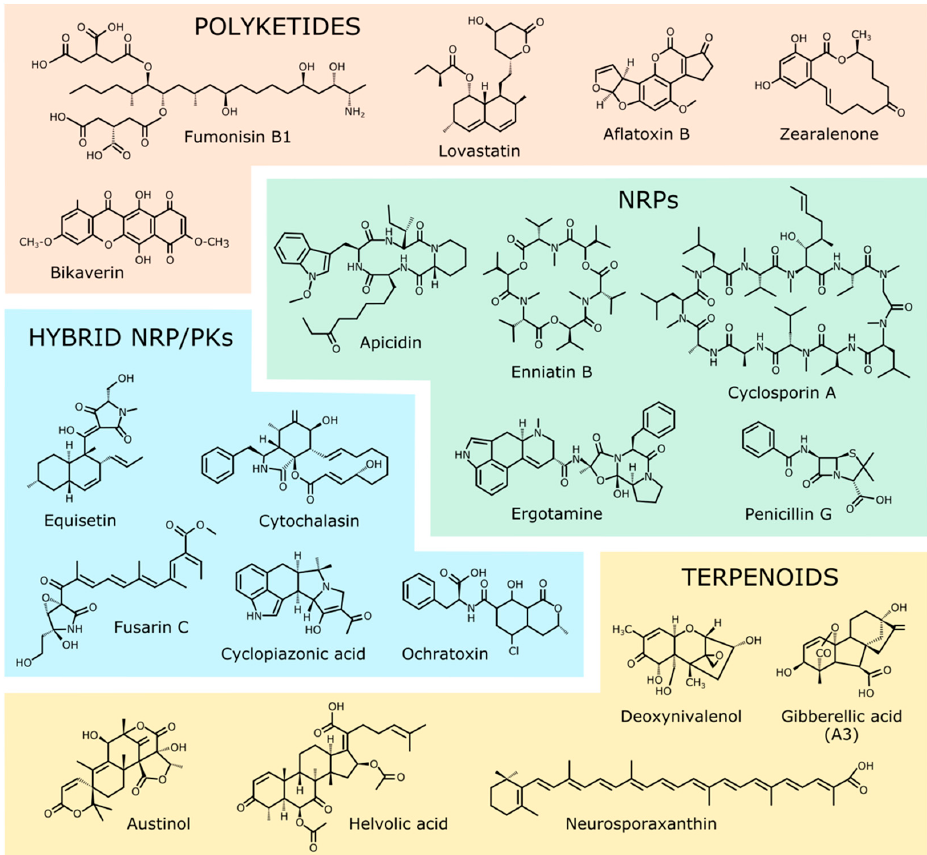
Figure 1. Chemical structures of the representative SMs from the four major families described in Table 1. Table